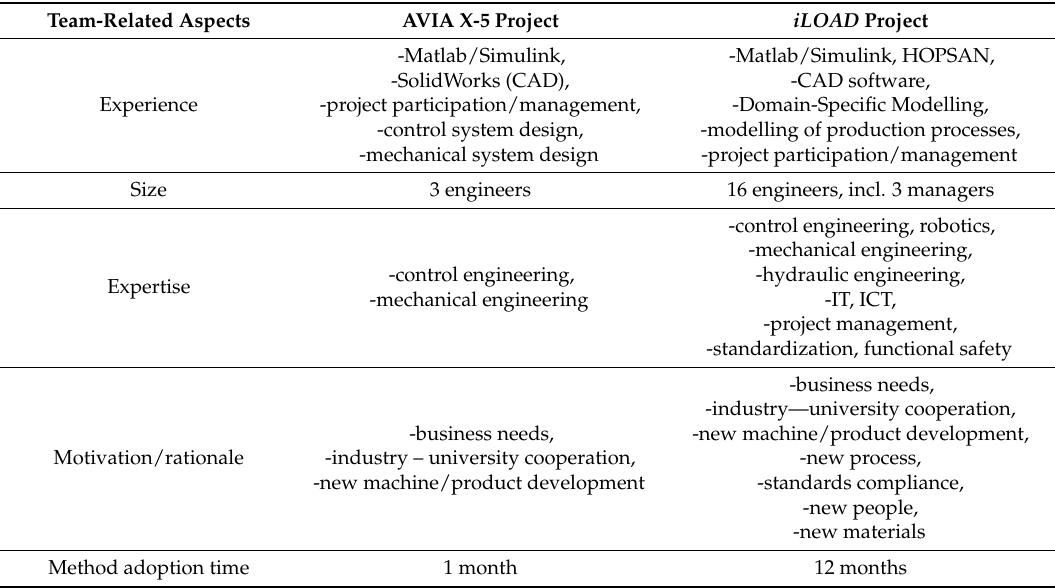
Table 3. Team-related aspects of the realized